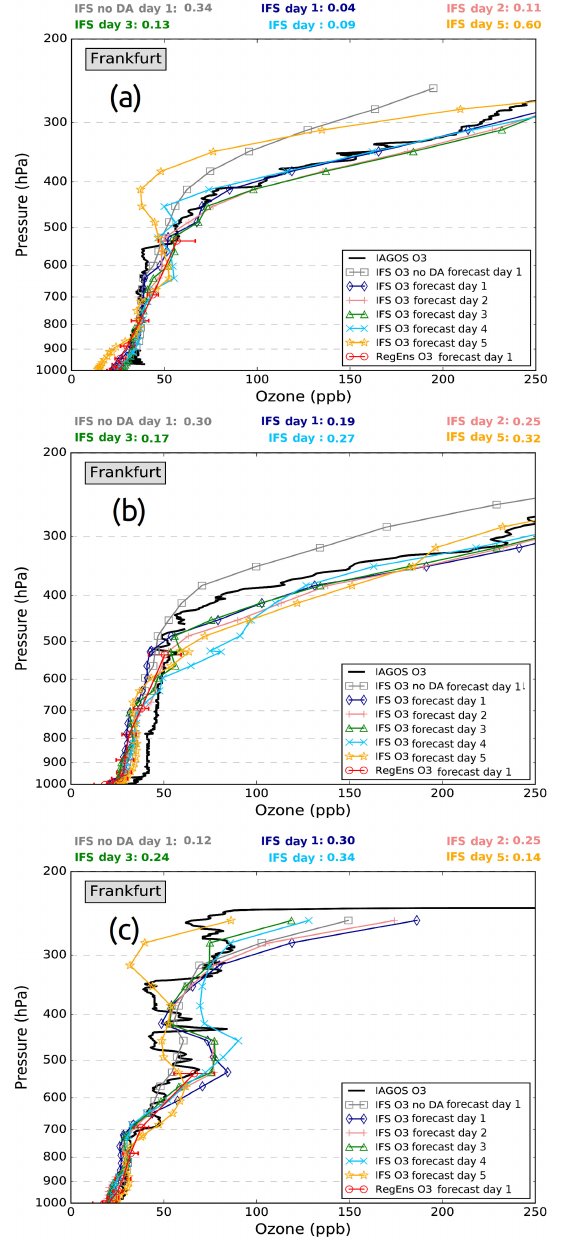
Figure 11. Profiles of ozone mixing ratio (ppb) over the broader area of Frankfurt (8.5 ◦ E, 50 ◦ N) for IAGOS (black line), IFS fore- cast day 1 (dark blue line), IFS forecast day 2 (coral line), IFS fore- cast day 3 (green line), IFS forecast day 4 (light blue line), IFS fore- cast day 5 (orange line), IFS no DA (without data assimilation) fore- cast day 1 (grey line) and RegEns (red line) during (a) 13:00Z on 4 January 2017, (b) 06:00Z on 5 January 2017, and (c) 13:00Z on 5 January 2017. The red bars denote the standard deviation among the regional ensemble members. The numbers above the diagrams show the FGE values of IFS ozone (with the corresponding colour) at 300–500hPa (a, b) and 400–600hPa (c) .